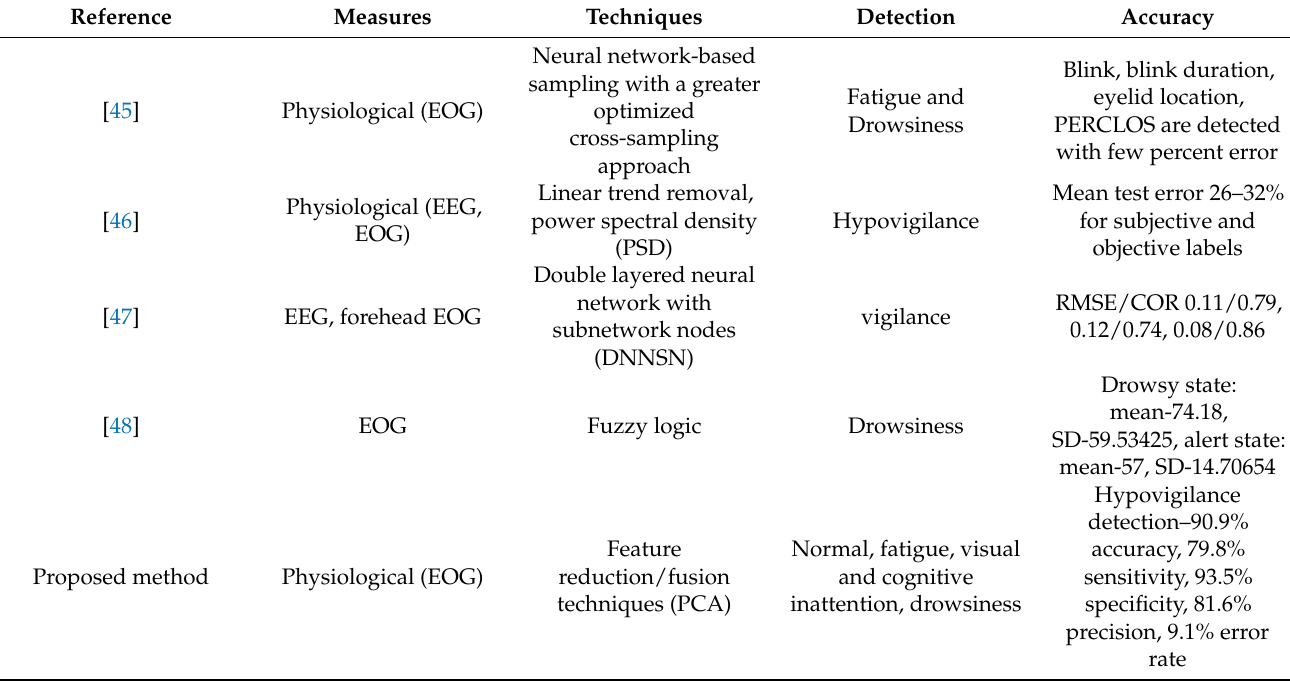
Table 5. Comparison of performance with the related